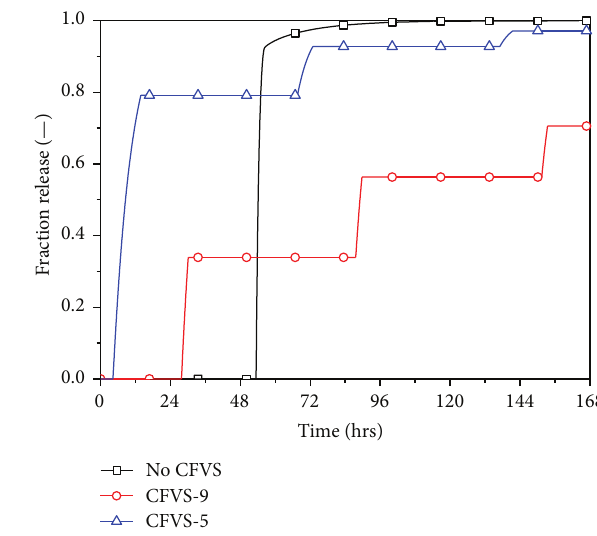
Figure 7: Comparison of fractional release of CsI in extended SBO.